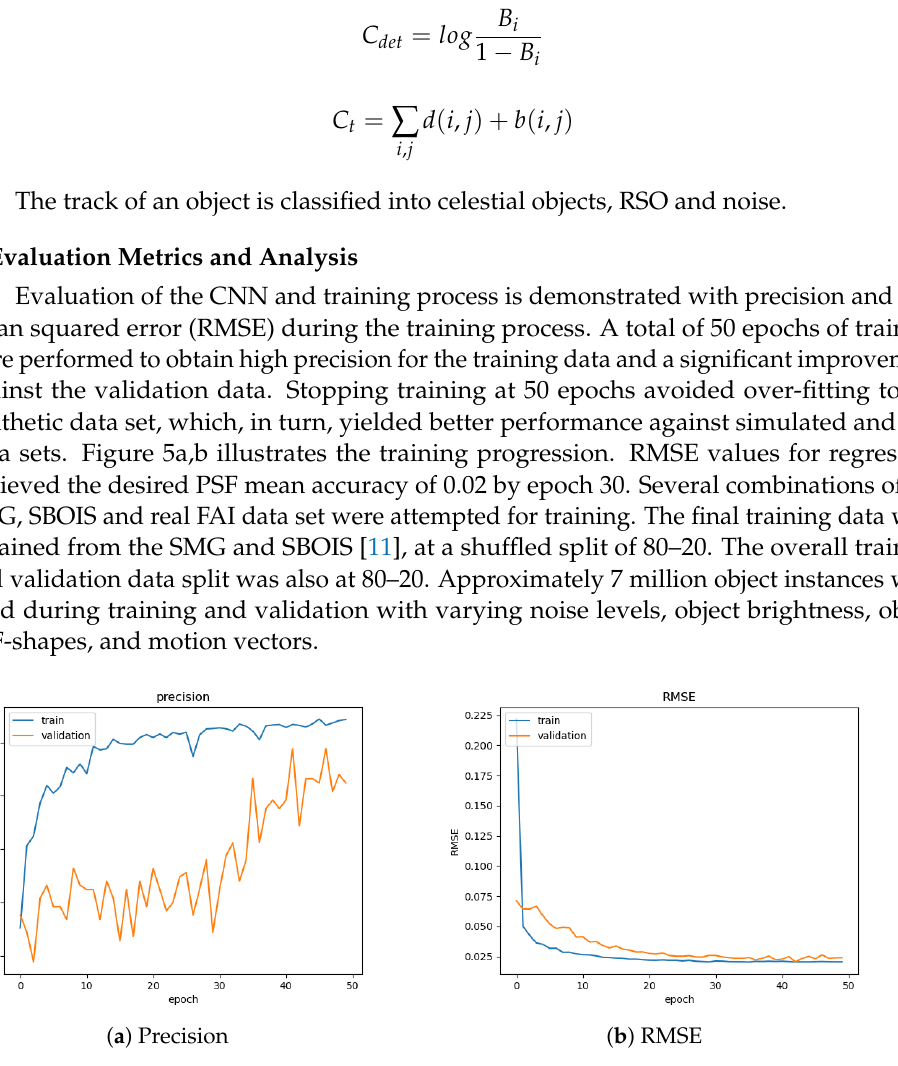
Figure 5. CNN training